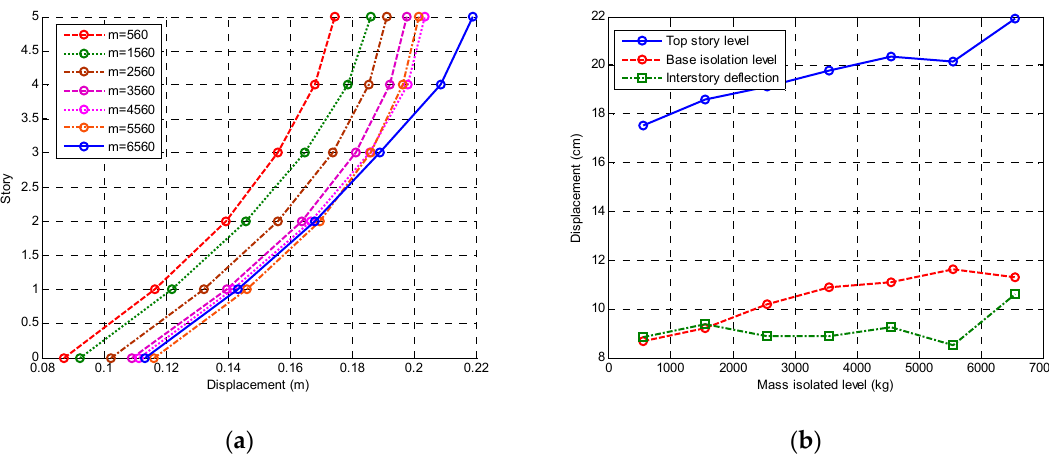
Figure 13. The results of ( a ) peak displacement for the different mass of isolated base and ( b ) peak displacement at the base isolation level and top story level for the different mass of isolated base under the El Centro earthquake.